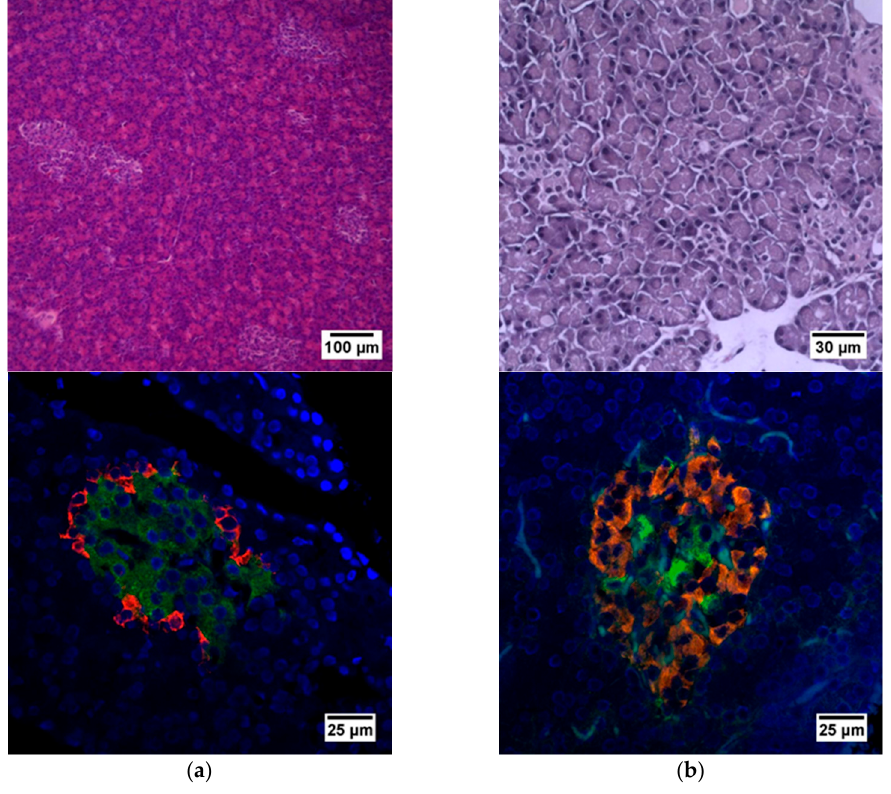
Figure 2. Histological and immunohistochemical analysis of rat pancreas. ( a ) An islet of Langerhans of a healthy rat, and ( b ) an islet of Langerhans of a rat with STZ-induced DM. Staining with hematoxylin and eosin. Staining with antibodies to glucagon (red) and to insulin (green) and nuclei (blue). 2.2. Live Cell Imaging of Islets in Whole Pancreas from Pig Models with STZ-Induced DM The day after the STZ injection, the pigs appeared weak, and one animal was